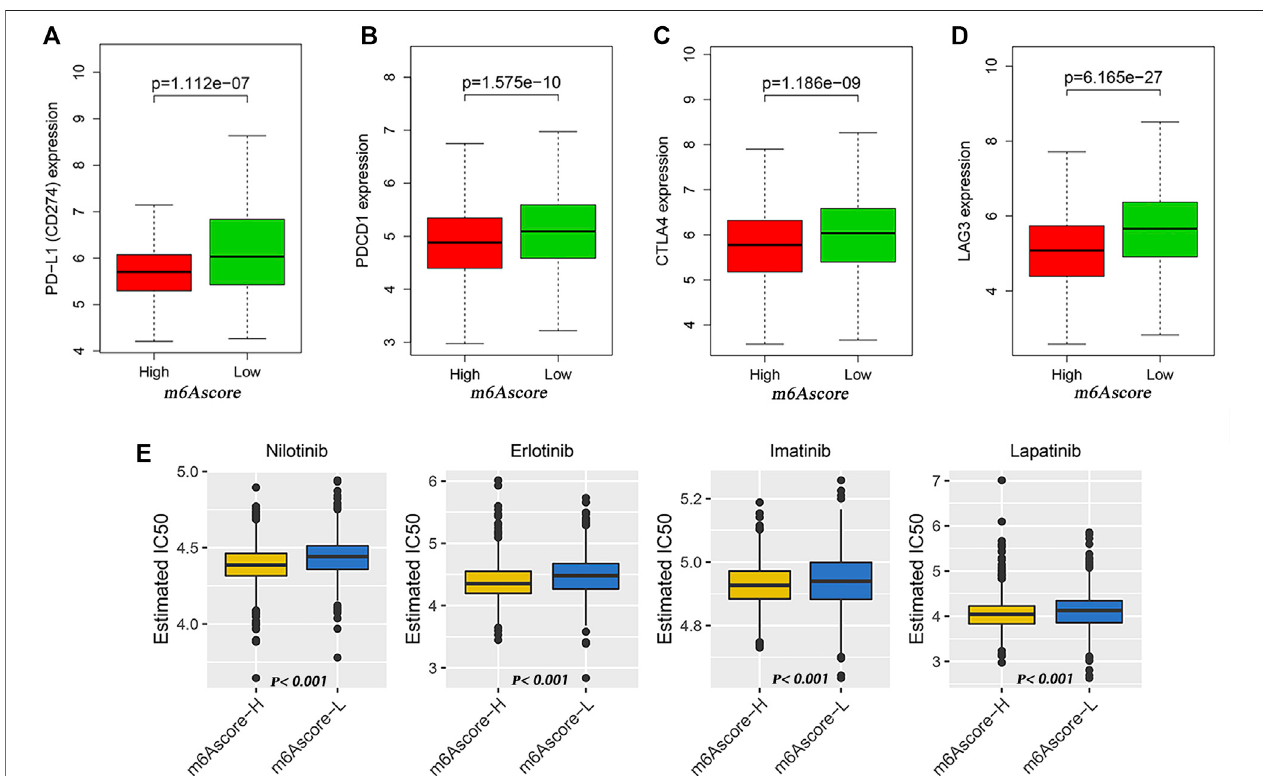
FIGURE 6 | Potential of m6Ascore in predicting therapeutic response. (A – D) Wilcoxon rank sum test shows signi fi cant differences in the expression of PD-L1 (A) , PDCD1 (B) , CTLA4 (C) and LAG3 (D) between low- and high-m6Ascore groups. (E) Comparison of drug sensitivity between high- and low-m6Ascore groups. Distribution of IC 50 of nilotinib, imatinib, erlotinib, and lapatinib between high- and low-m6Ascore